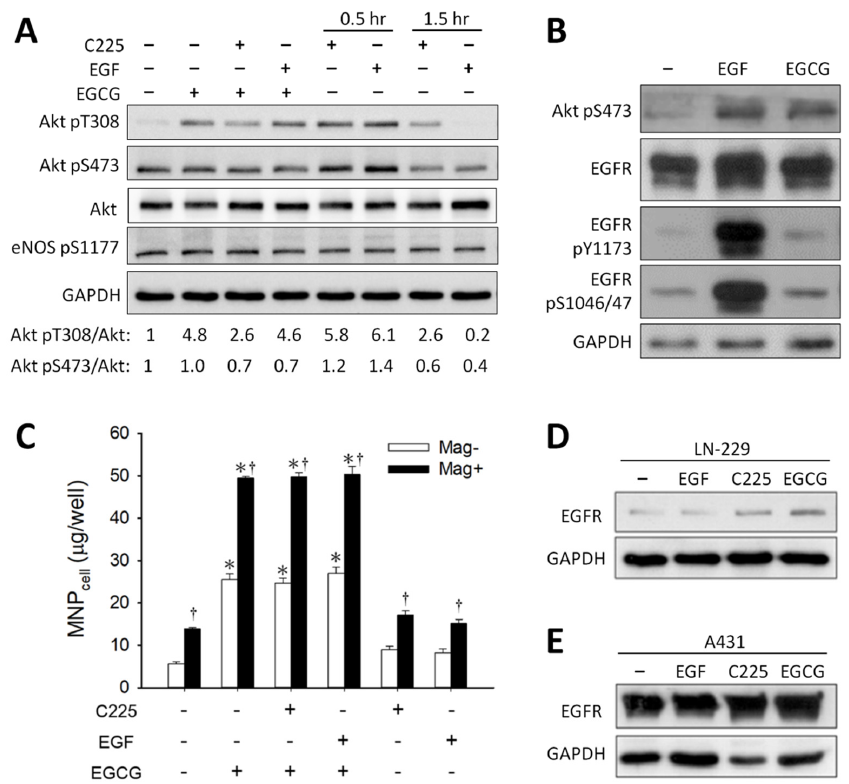
Figure 6. EGCG- and EGF-induced Akt phosphorylation of glioma cells. Western blot analysis was conducted in ( A ) LN-229 cells pretreated with C225 (5 μ g/mL) or EGF (50 ng/mL) for 30 min prior to exposure of the cells to EGCG (25 μ M) for 1 h; ( B ) A431 cells were treated with EGF (50 ng/mL)